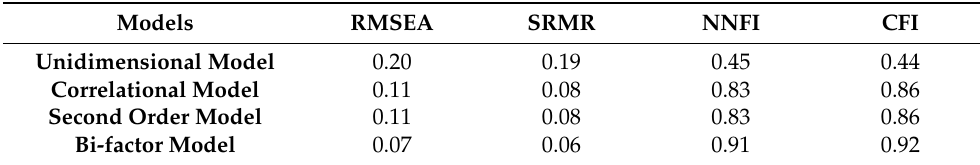
Table 1. Confirmatory Factor Analysis of Italian version of the GRAT–RS: Goodness of Fit .